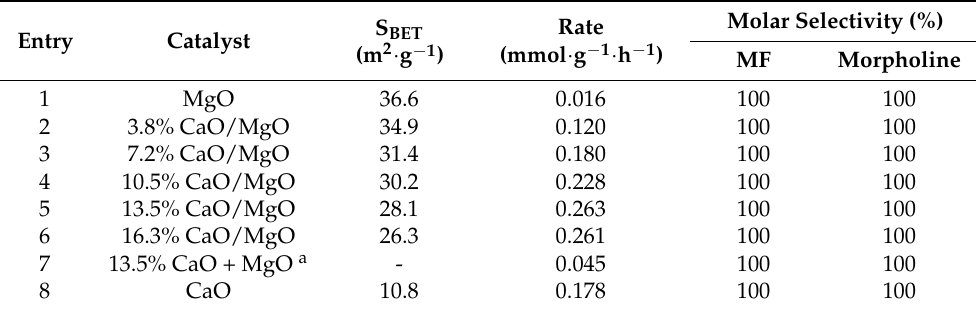
Table 2. Alcoholysis rate of NFM and product selectivities over different CaO/MgO catalysts.